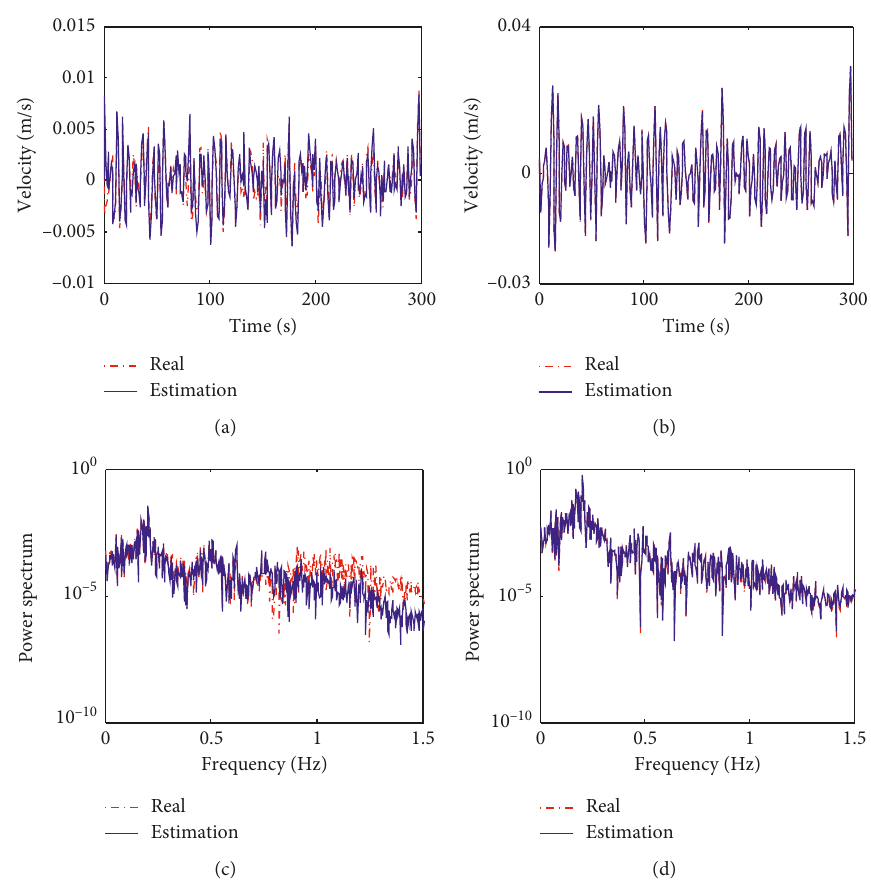
Figure 16: Comparison of the structural velocity responses in direction X under wind direction of 180 ° . Time history on the (a) 24th floor and (b) 58th floor. Power spectrum on the (c) 24th floor and (d) 58th floor.